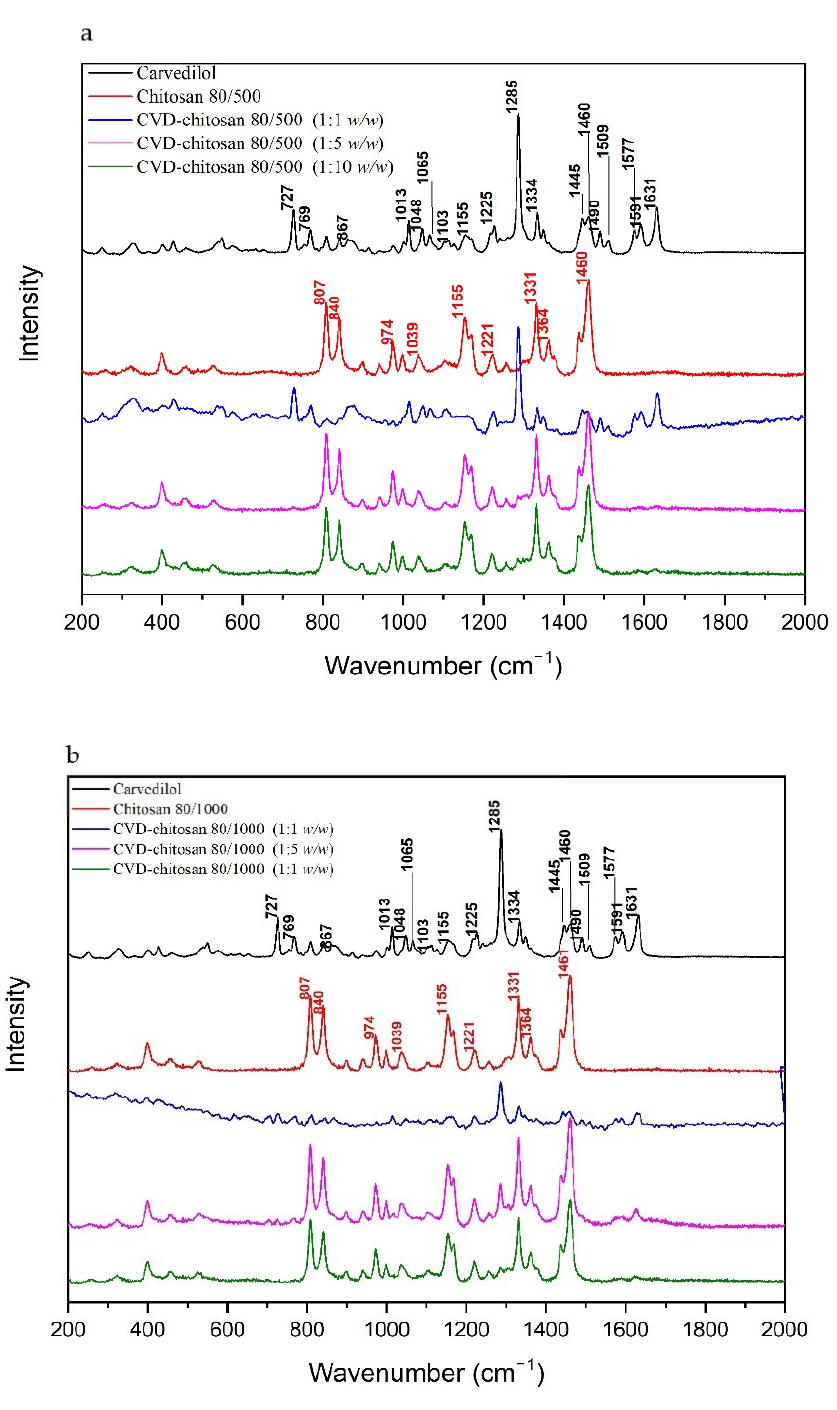
Figure 3. Raman spectra of the solid systems of: CVD-chitosan 80/500 ( A ) and CVD-chitosan 80/1000 ( B ) ( λ = 785 nm) at room temperature.